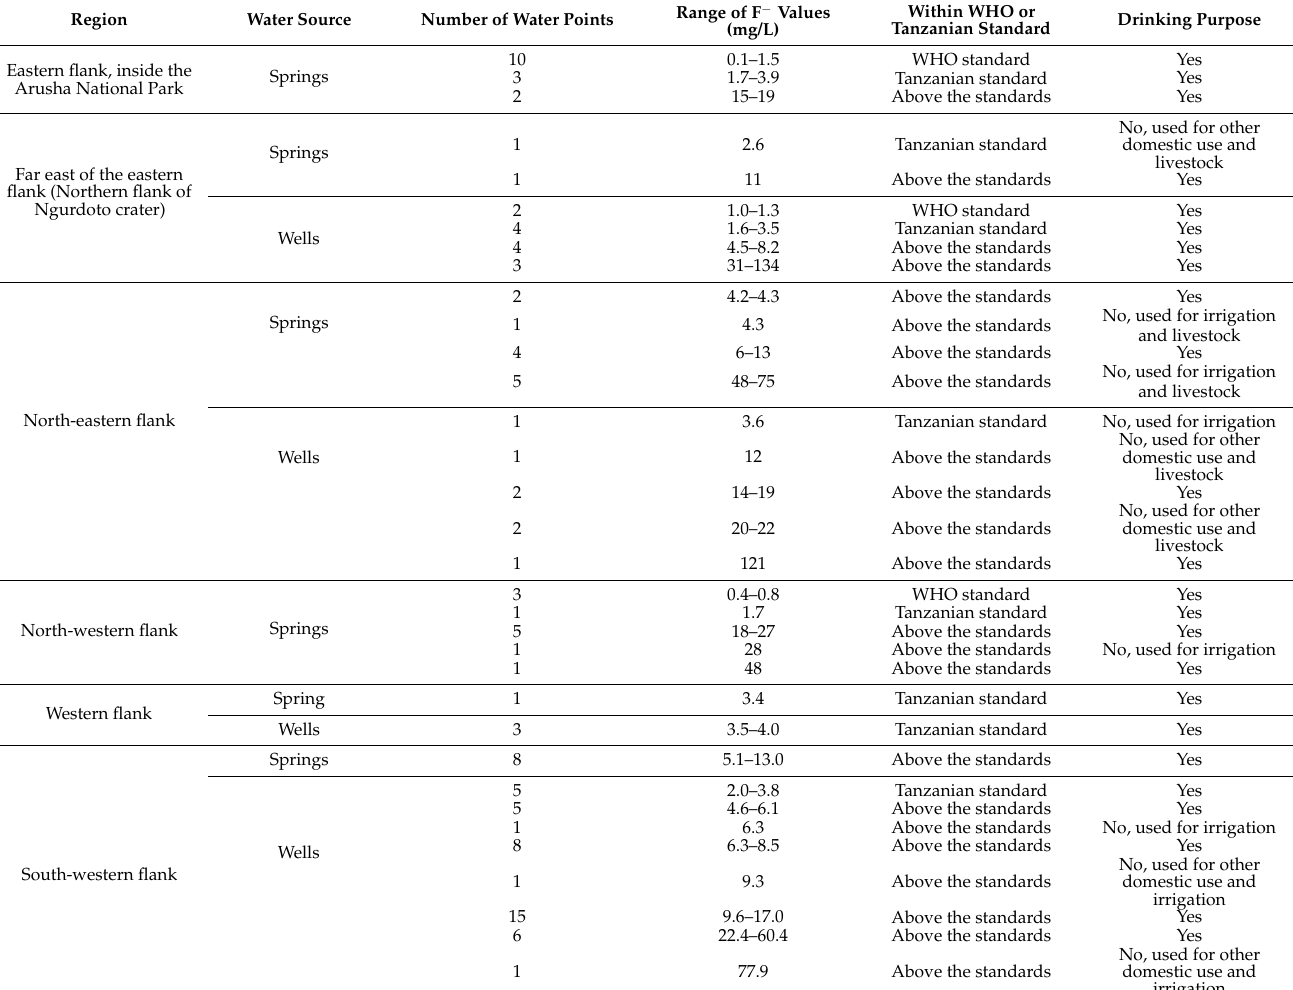
Table 9. Overview of the usable groundwater sources from the sampled inventoried groundwater points in reference to their F − concentrations (F − upper limits recommended for drinking water: WHO = 1.5 mg/L; Tanzanian = 4.0 mg/L). Region Water Source Number of Water Points Range of F − Values